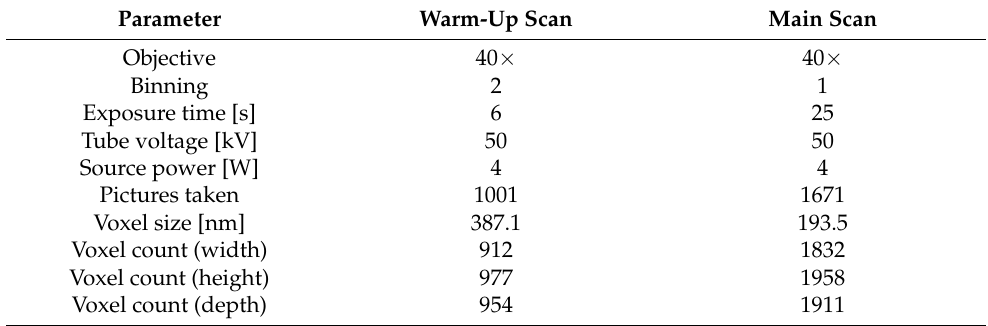
Table 1. Parameters of the µ-CT